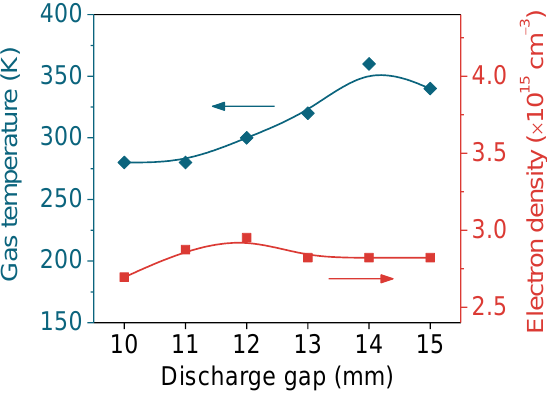
Figure 10. Effects of the discharge gap on gas temperature and electron density.